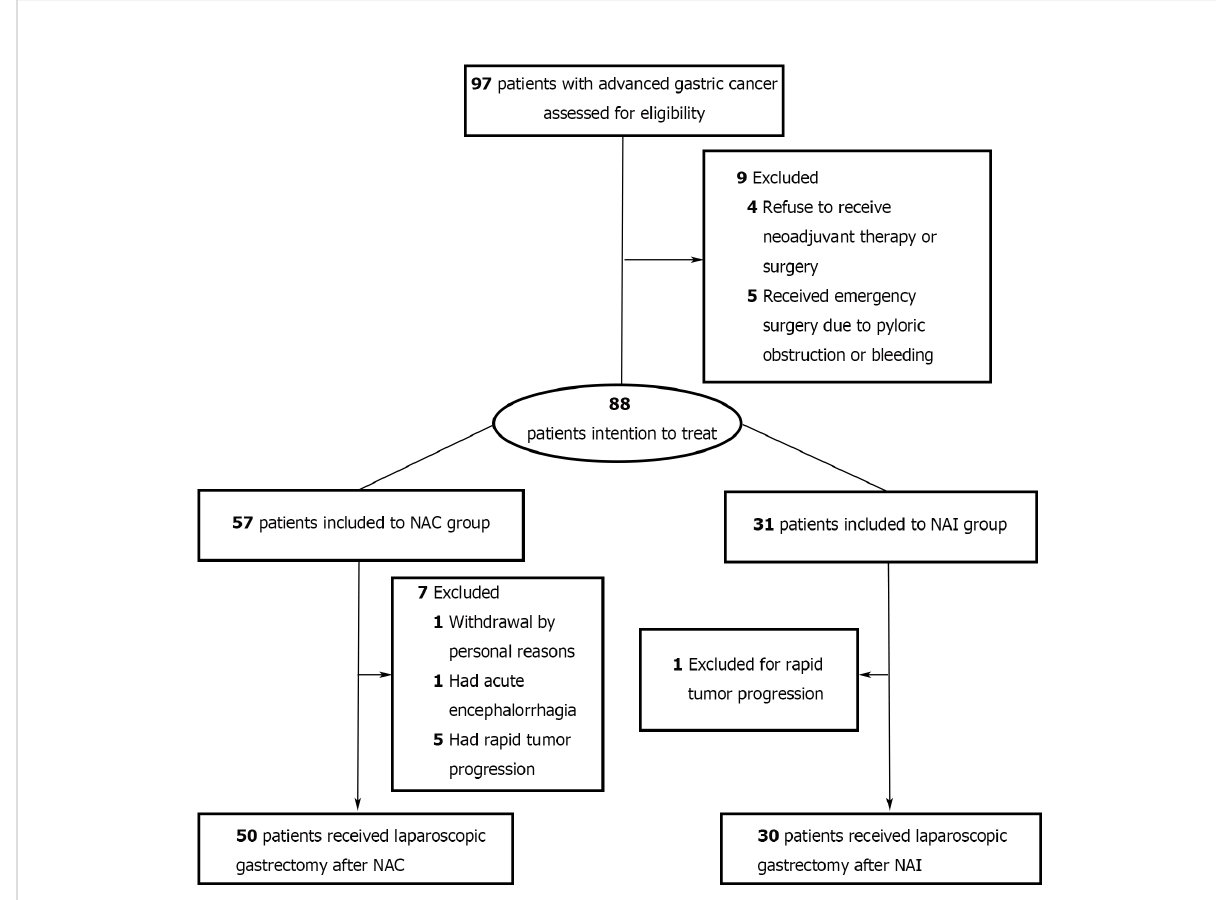
FIGURE 1 Study fl ow diagram. NAI, neoadjuvant immunotherapy; NAC, neoadjuvant